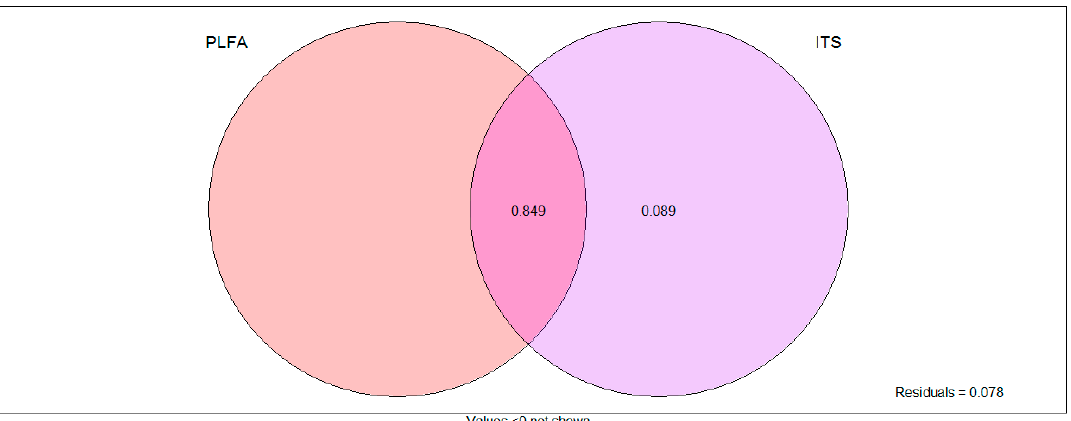
Figure 8. Variation partitioning analysis (VPA) of TDW based on PLFA profile and fungal ITS as explanatory variables under aCO 2 and eCO 2 . TDW, plant total dry biomass; PLFA: 32 main PLFAs, ITS: fungal OTUs. The numbers are the percentages of the total variables explained by the factors.